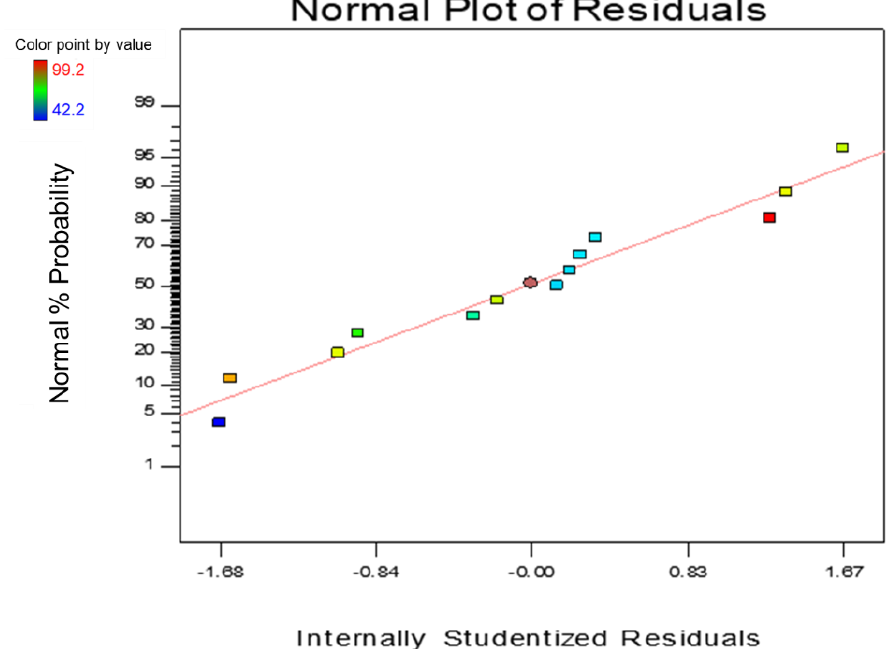
Figure 13. Normal plot of residuals for water contact angle optimisation.